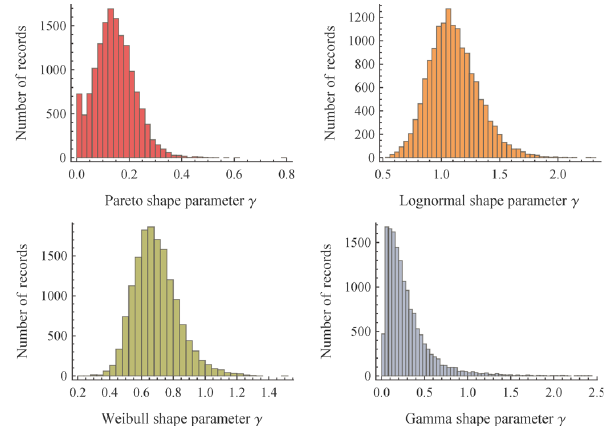
Fig. 5. Mean ranks of the tails for all records. The best-fitted tail is ranked as 1 while the worst-fitted as 4. A lower average rank indicates a better performance.